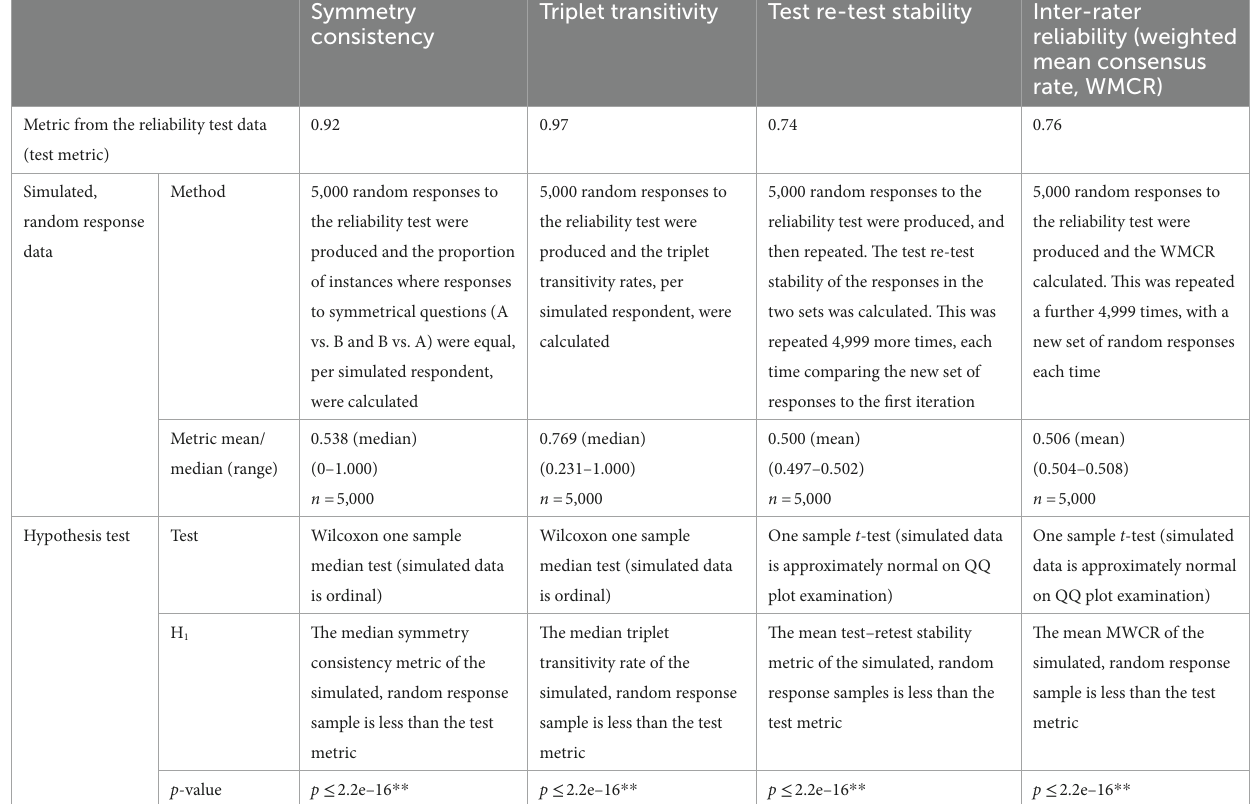
TABLE 3 Inter and intra-rater reliability metrics compared to simulated, random responses ** p ≤